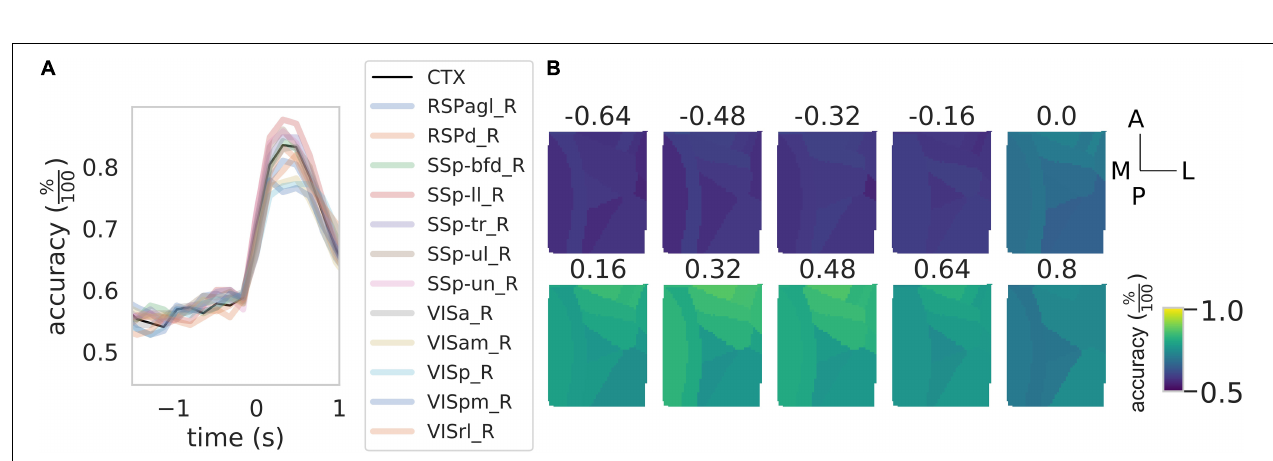
FIGURE 3 | High accuracy in the detection of the rewarded pull. (A) Accuracy of the detection of the rewarded pull for the different experimental groups as a function of the time window considered in a loto scheme. Solid lines represent the accuracy obtained when considering the entire field of view, while the shaded lines represent the result of the classification for the 12 parcels in the field of view. (B) Accuracy of the detection of the rewarded pull for the different experimental groups as a function of the time window considered in a loso scheme. Solid lines represent the average across all tested subjects while the shaded region represents the 95% confidence interval of the mean. In both (A,B) the value of the x -axis represents the time of the last frame in the sliding window used for the analysis.